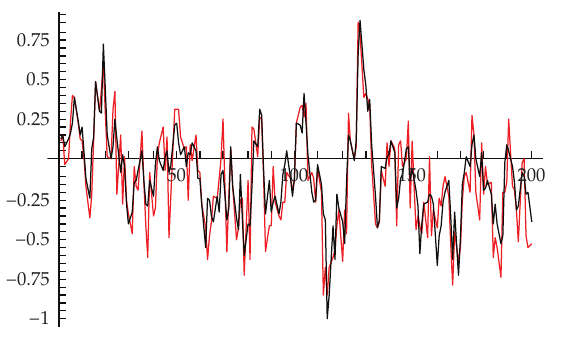
Figure 3: x 1 (cid:5) k (cid:6) and (cid:11) x 1 (cid:5) k/k (cid:6) versus k .